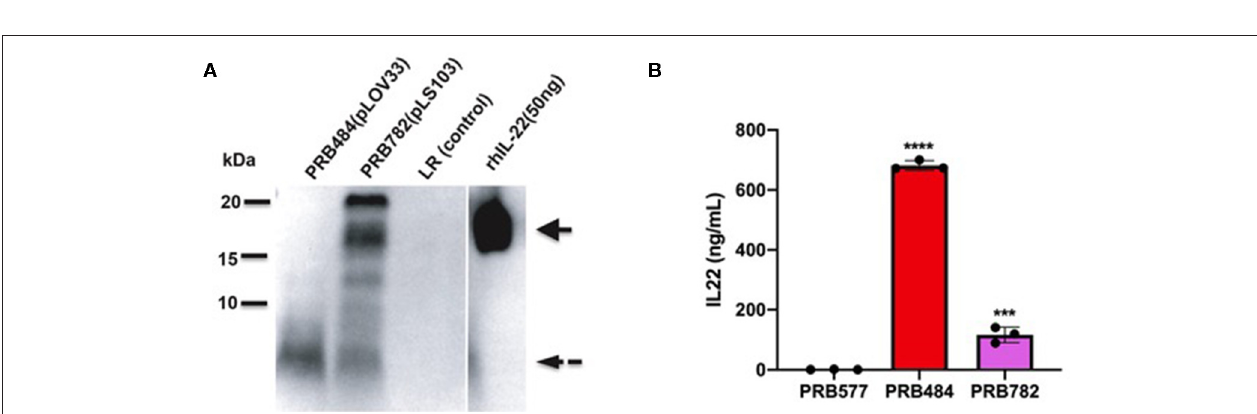
FIGURE 4 | PRB782 shows improved processing of secreted hIL-22. (A) Western blot of bacterial supernatant from PRB782, PRB484, and PRB577 shows new strain of recombinant L. reuteri (PRB782) with production of more intact hIL-22. (B) hIL-22 ELISA showing lower concentrations of secreted hIL-22 from PRB782 as compared to PRB484. Data are mean of n = 3 with error bars representing deviation from the mean; comparisons performed with t -tests (two groups) or analysis of variance (ANOVA) (multiple groups). *** P < 0.001, **** P <